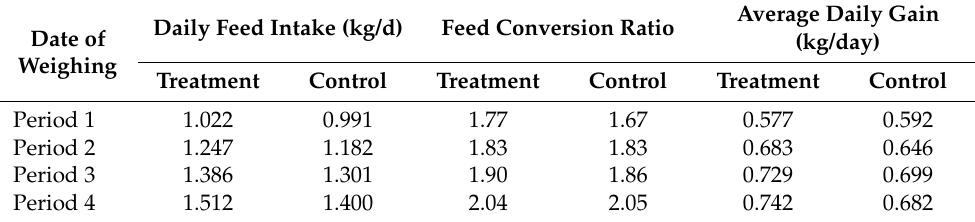
Table 5. Daily feed intake, feed conversion ratio and average daily gain of weaners on treatment and control